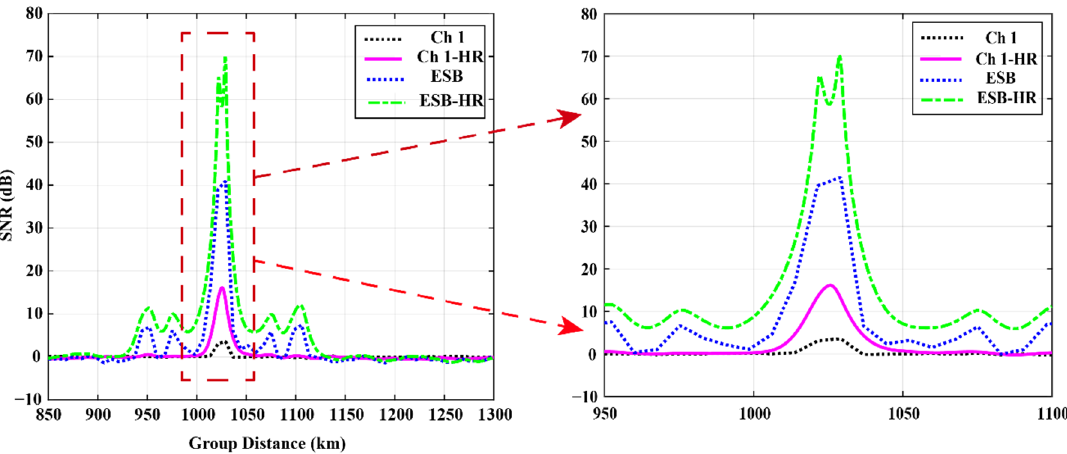
Figure 13. Comparison of SNR at 11.05 MHz under different conditions after subtracting background noise.